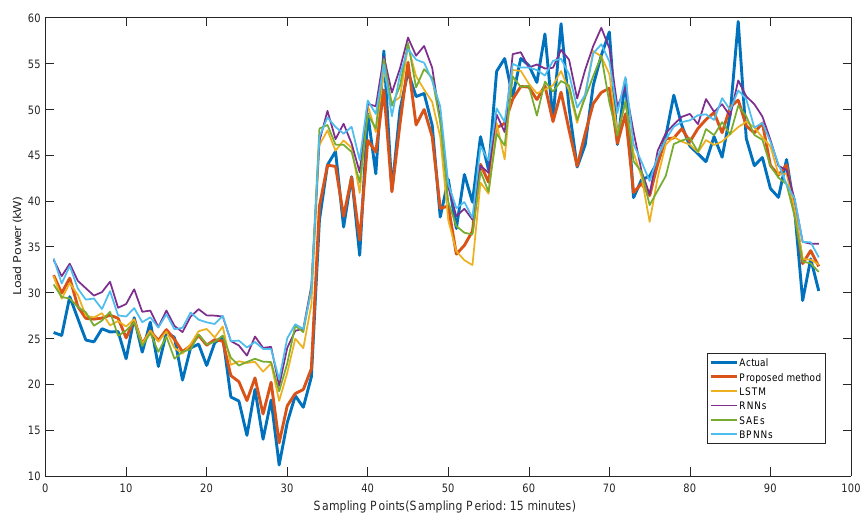
Figure 17. The load curves of Customer 53990001 based on the proposed method and the other current